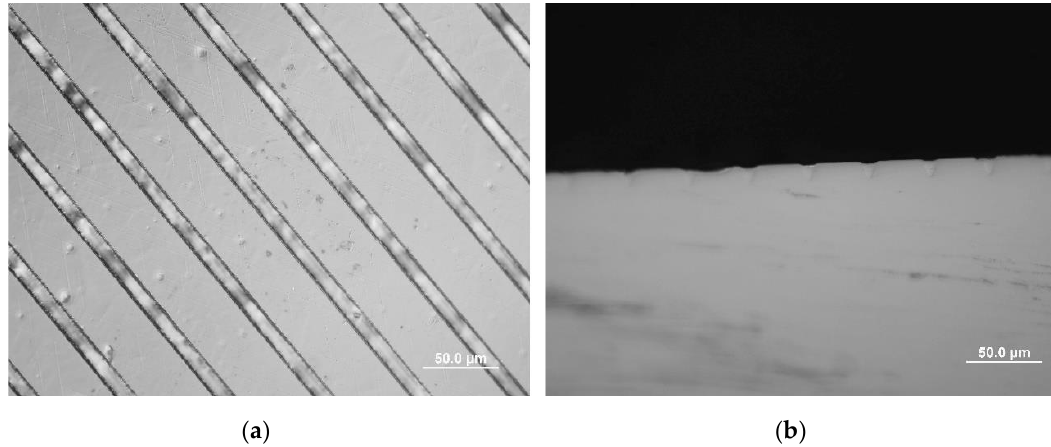
Figure 7. Optical micrographs showing an example of liquid phase epitaxial growth of lithium niobate on a lithium tantalate substrate at a temperature 0.5 °C below saturation temperature for ten minutes ( a ) top view; ( b ) end view.